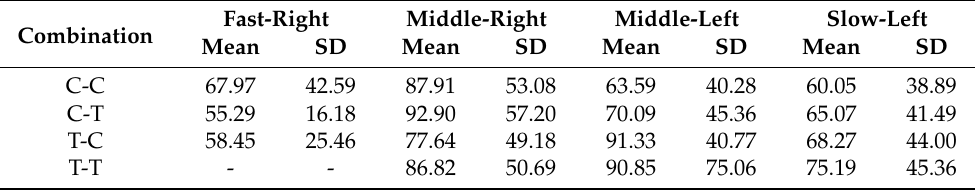
Table A7. The mean and standard deviation of ∆ D of m and